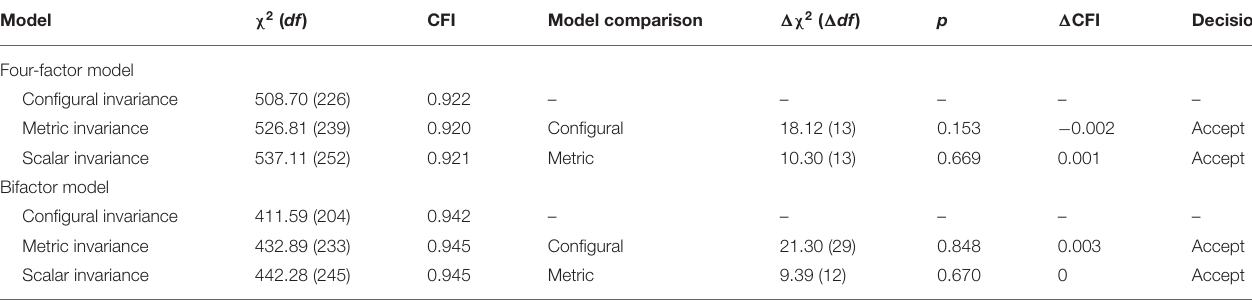
TABLE 6 | Tests for measurement invariance of the correlated four-factor and the bifactor DARS model.